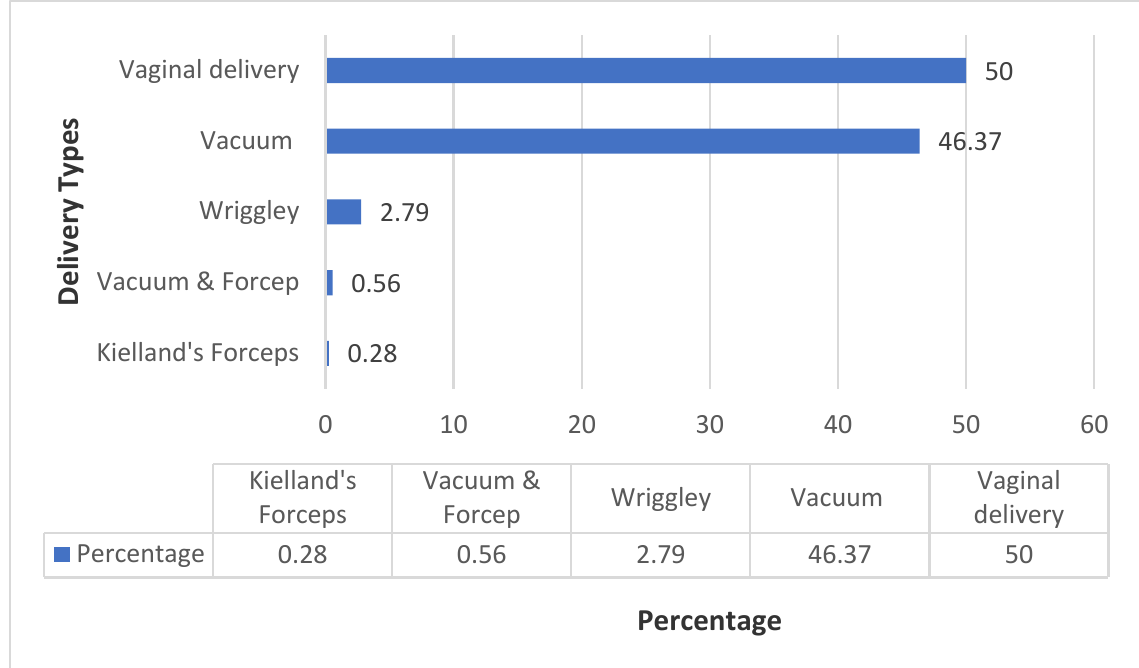
Figure 7. Types of operative vaginal delivery at the two hospitals.